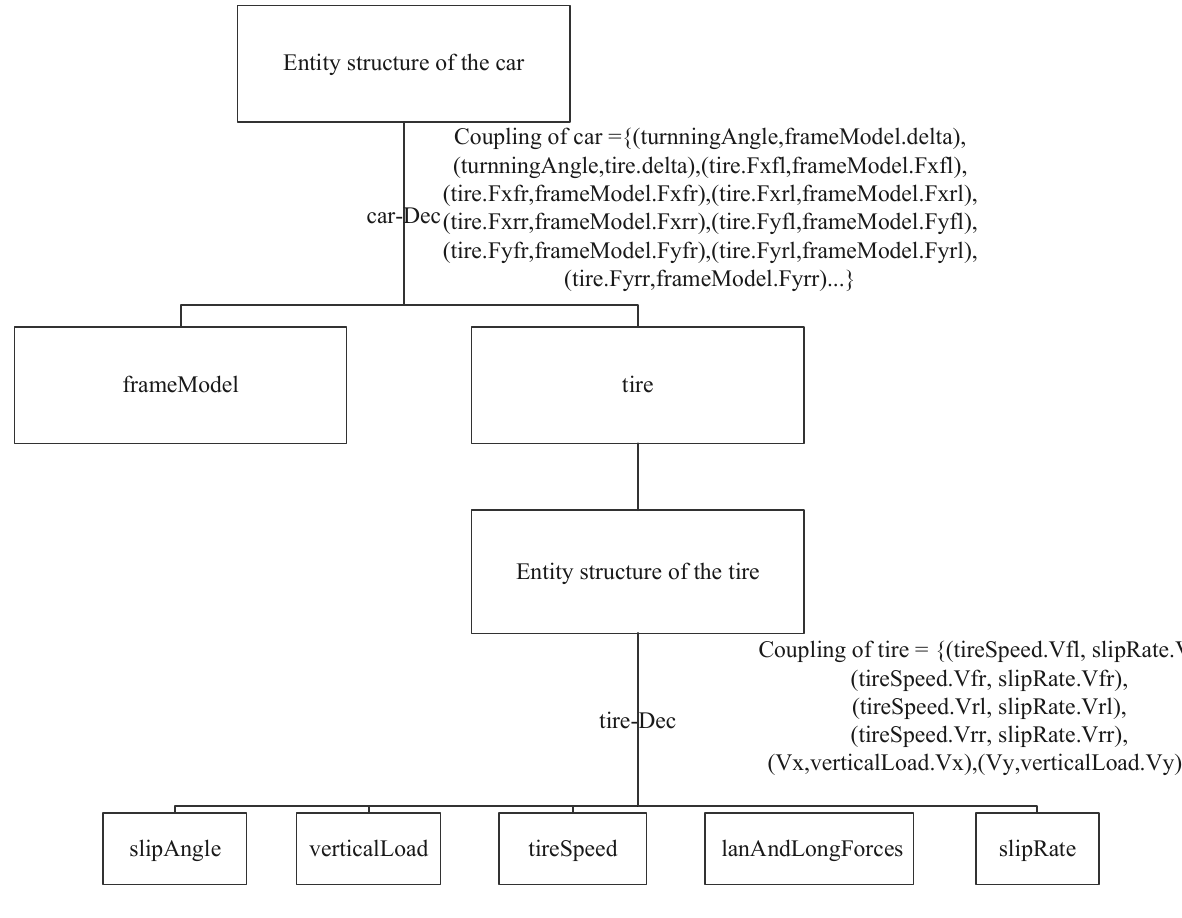
Figure 13. Pruned SES-X model of a car.